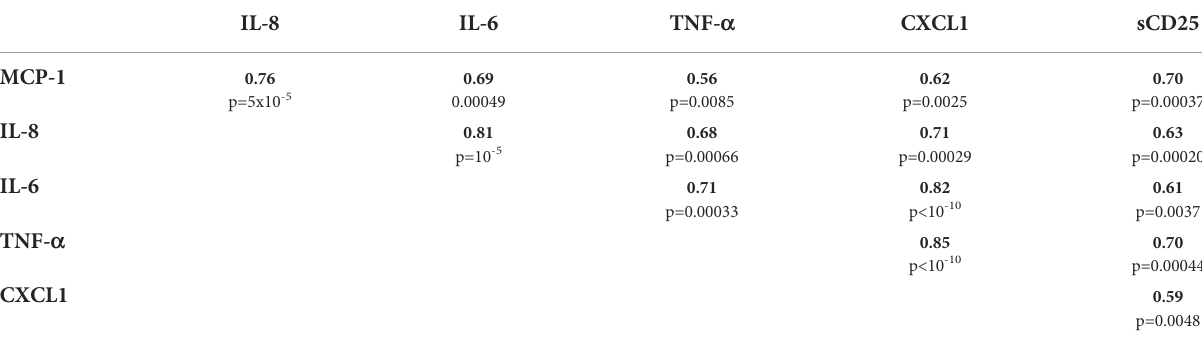
TABLE 2 Correlations between levels of some cytokines and sCD25 in glioblastoma cyst fl uid.